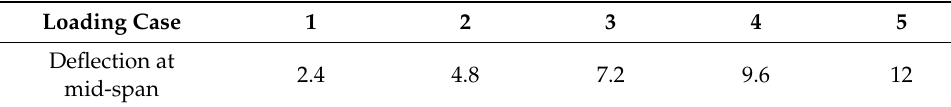
Table 3. Beam deflection under different cases (units: